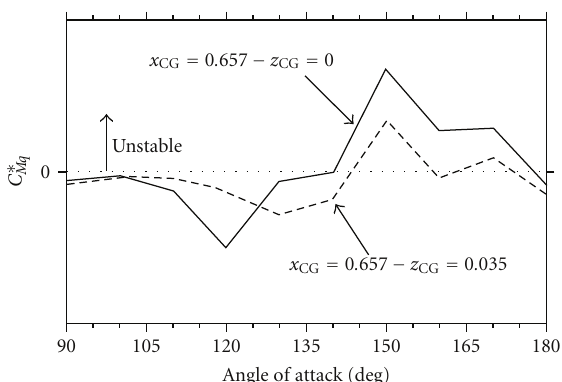
Figure 10: The aerodynamic coe ffi cients of the payload (pitching moment dynamic stability)